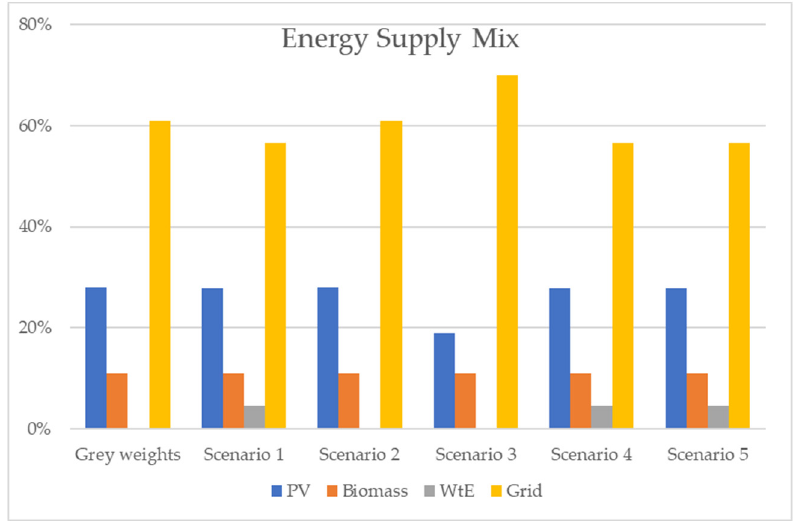
Figure 1. Optimal energy supply mix through different weighting scenarios, data from Bakhtavar et al. [57]